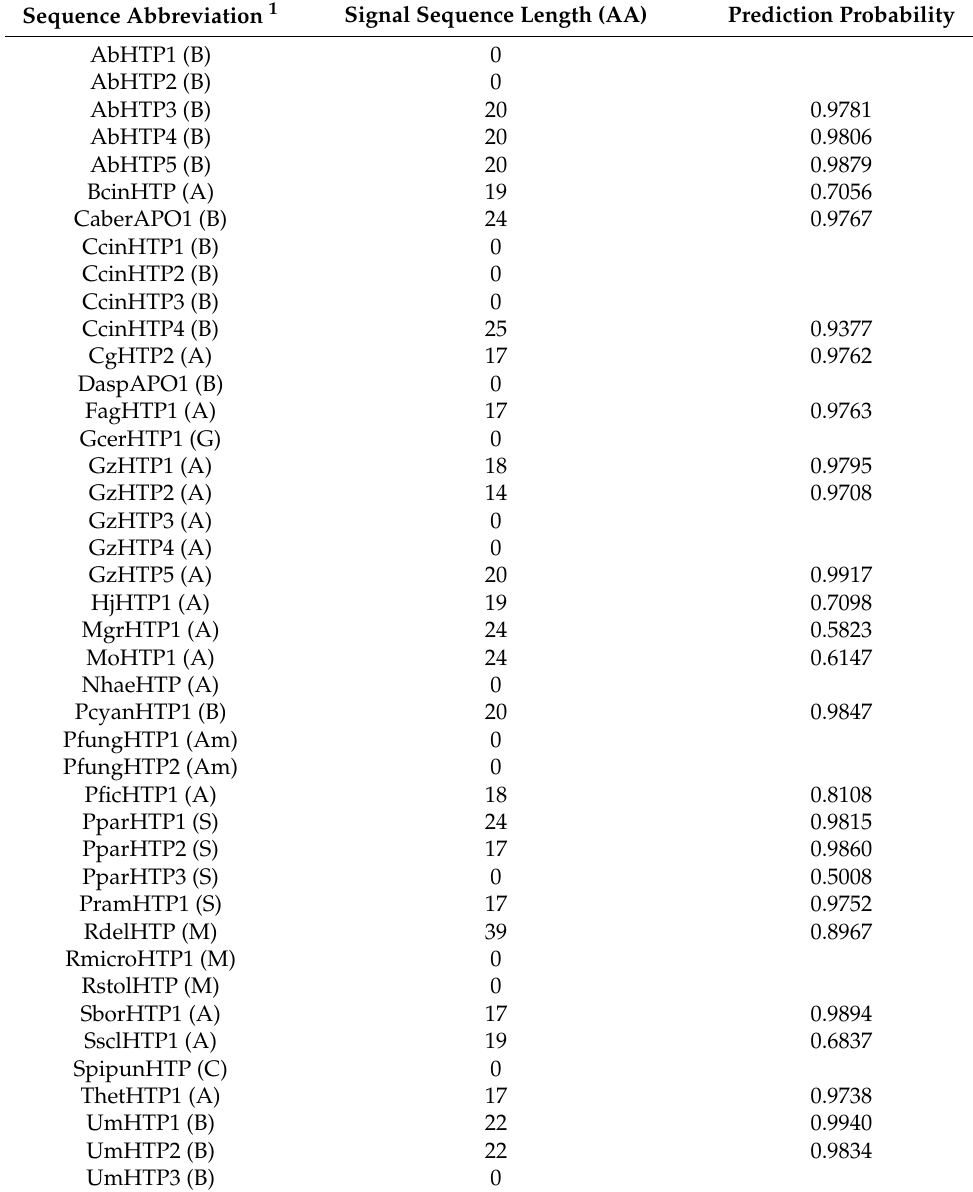
Table 1. Prediction of N-terminal signal peptide (Sec/SPI) in selected sequences of heme peroxyge- nases (HTP) for the Sec pathway over the endoplasmic reticulum membrane. Performed with [13] by using the default parameter setting for eukaryotic protein